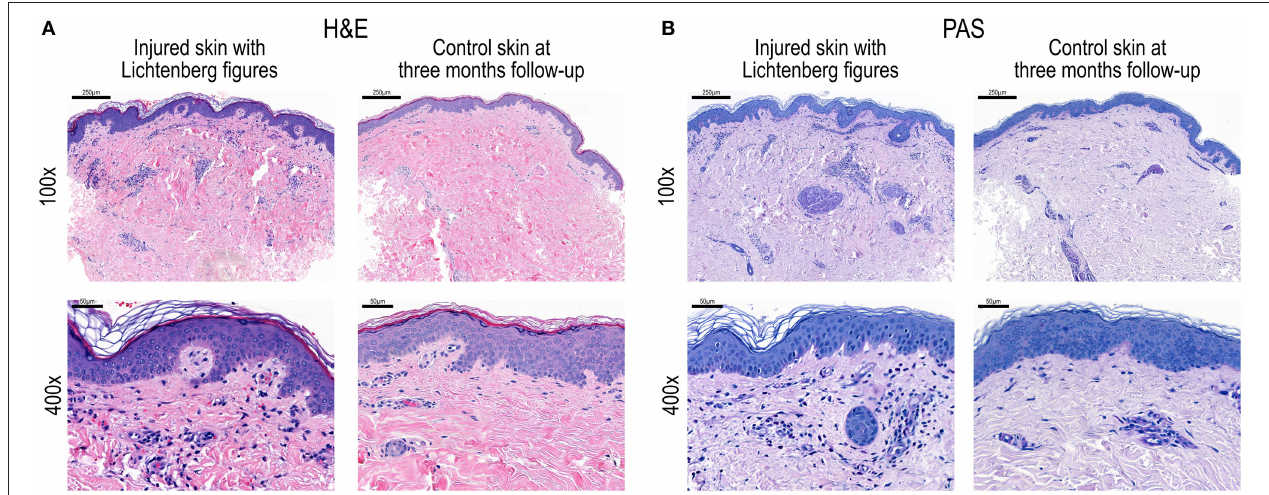
FIGURE 2 | (A) Haematoxylin and Eosin (H&E) staining and (B) Periodic acid-Schiff (PAS) staining of skin biopsy sections after electric injury and Lichtenberg figures and at 3 months follow-up as control. Magnifications 100 × and 400 ×